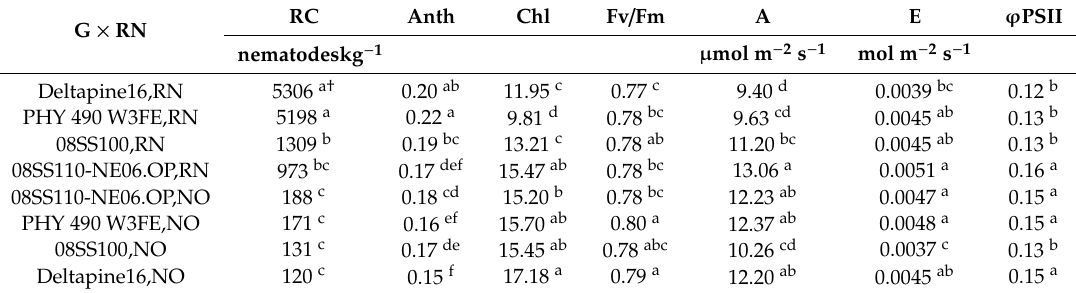
Table 12. Interaction e ff ect of genotype (G) and reniform nematode (RN) treatment e ff ects on reniform nematode population and physiological parameters of cotton genotypes at 60 days after planting. G ×